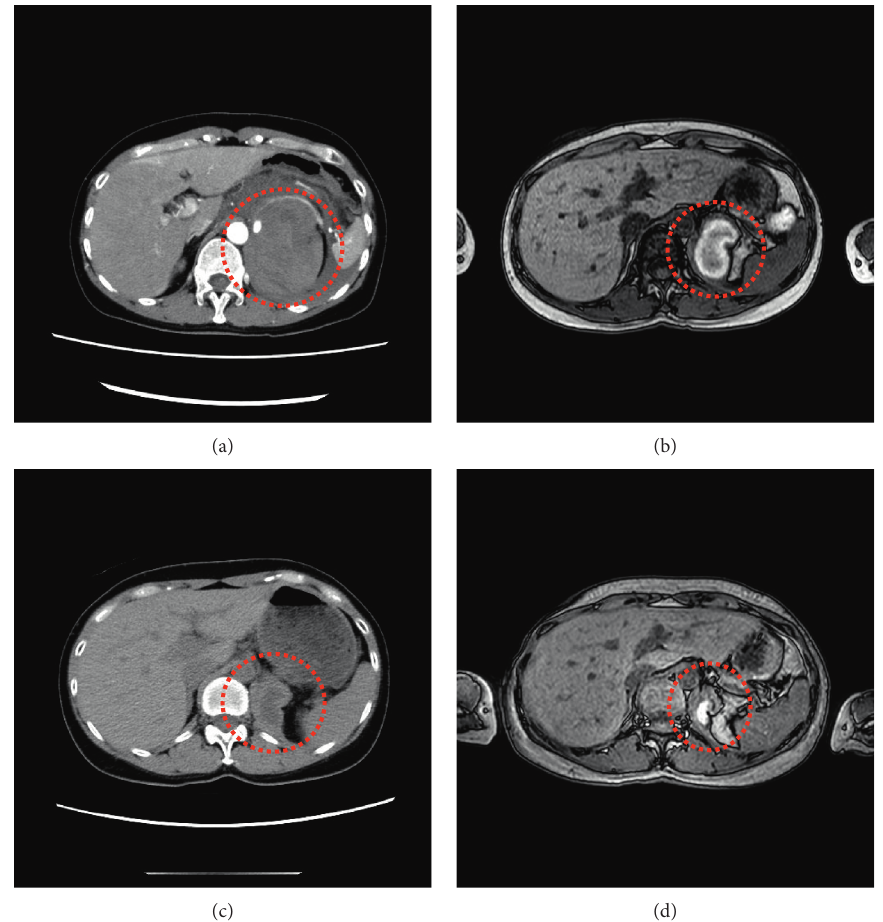
Figure 2: Change in imaging findings. (a) Contrast-enhanced axial computed tomography on admission indicated a left adrenal mass and a large retroperitoneal hemorrhage (red dots). (b) T1-weighted magnetic resonance imaging after a month discharge showed tumor shrinkage of a left adrenal mass and the reduction of hematoma (red dots). (c) Plain axial computed tomography three months after discharge indicated a 2.8cm left adrenal mass and hematoma (red dots). (d) T1-weighted magnetic resonance imaging five months after discharge showed even more tumor shrinkage and the reduction of hematoma (red